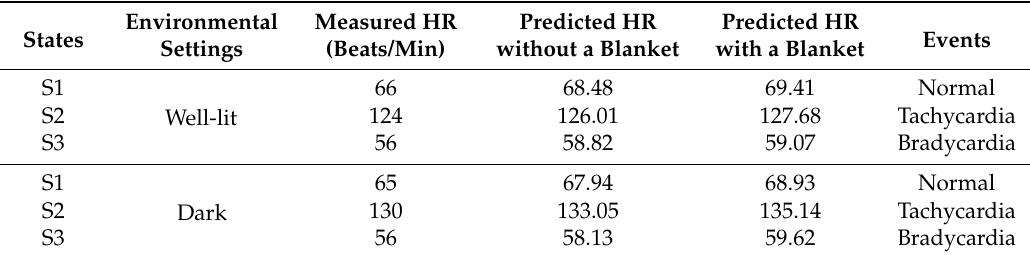
Table 3. Abnormal cardiac events for adult participant at two environmental